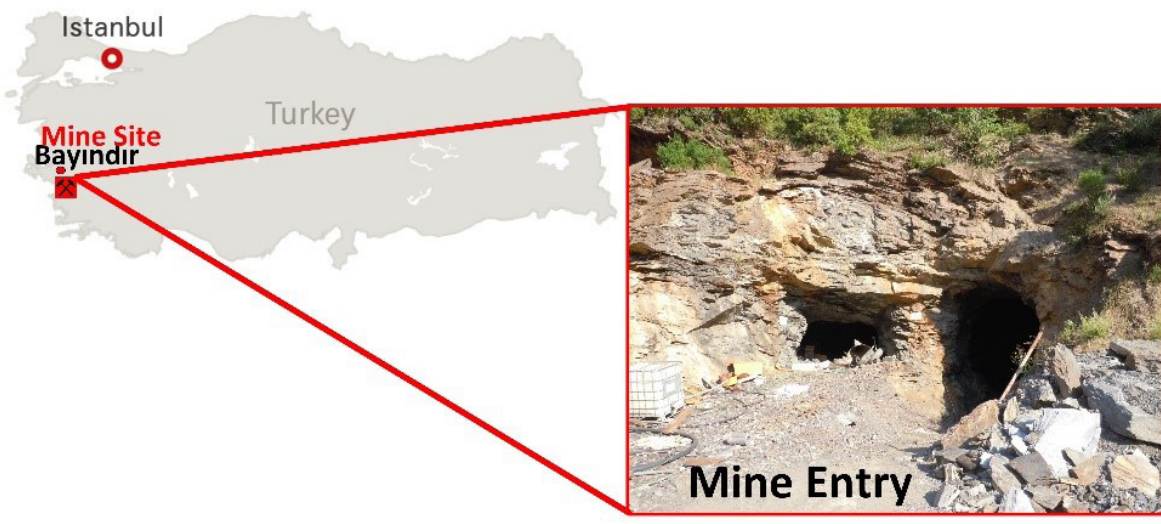
Figure 1. Location map of mine